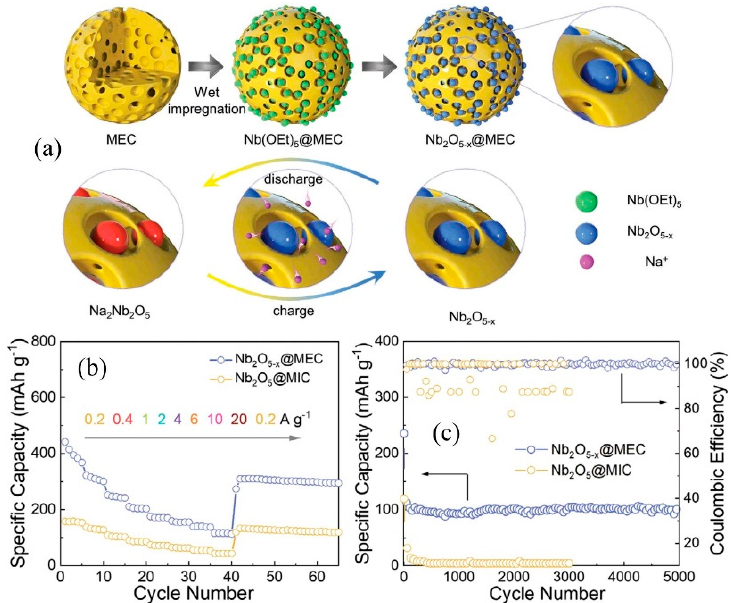
Figure 6. ( a ) Schematic illustration of the synthetic procedure of Nb 2 O 5 − x @MEC composites. ( b ) Rate performance and ( c ) long-term cycling performance under the current density of 20 A g − 1 of Nb 2 O 5 − x @MEC electrode. Reproduced with permission from Ref. [79] Copyright 2022 Wiley.